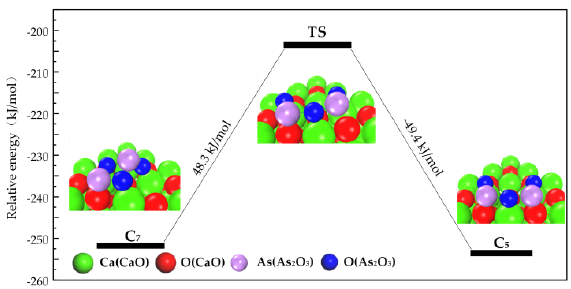
Figure 4. Transformation path of Category III.